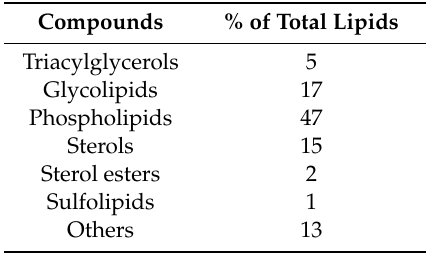
Table 4. Lipids content of apple flesh [8].